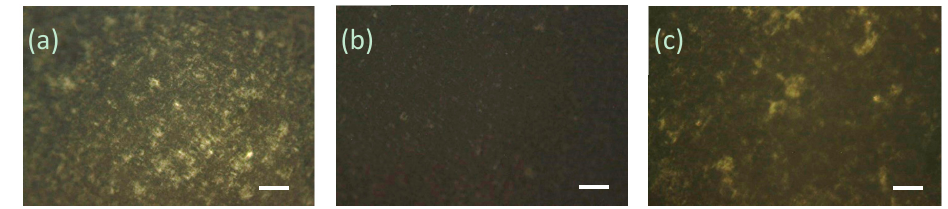
Figure 3. Cross-polarized microscopy images of ( a ) as-prepared ( b ) ammonia- and ( c ) carbon dioxide- treated CNC–organoclay colloidal nanocomposite hydrogels, scale bar = 100 μ m.